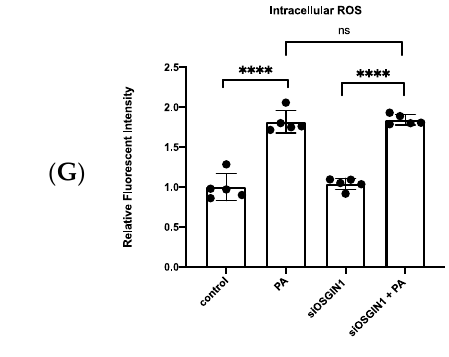
Figure 5. PA-induced OSGIN1 against endothelial dysfunction. ( A ) The heatmap demonstrates 19 XBP1s target genes whose expression > 2.0 log2 fold changes in the silencing of XBP1s (siXBP1s), compared to siRNA control cells after PA treatment. The mRNA levels of ( B ) XBP1s, ANGPTL4, CCND2, TXNIP, ( B , D ) OSGIN1, and ( D ) LC3B were analyzed with qRT-PCR. ( C ) The protein expression of OSGIN1 after the silencing of XBP1s. ( E ) The protein expression of OSGIN1, p-eNOS, and LC3 II/I after the silencing of OSGIN1. ( F ) Wound healing assay after silencing OSGIN1 combined treatment with PA. ( G ) Intracellular ROS was detected by DCFDA assay after silencing OSGIN1 combined treatment with PA. Data are presented as the mean ± SEM, and the images are representative of three independent groups. Data from multiple groups were analyzed by one-way ANOVA, followed by Tukey’s post hoc test. * p < 0.05, ** p < 0.01, *** p < 0.001, **** p < 0.0001, respectively. ns: not significance.